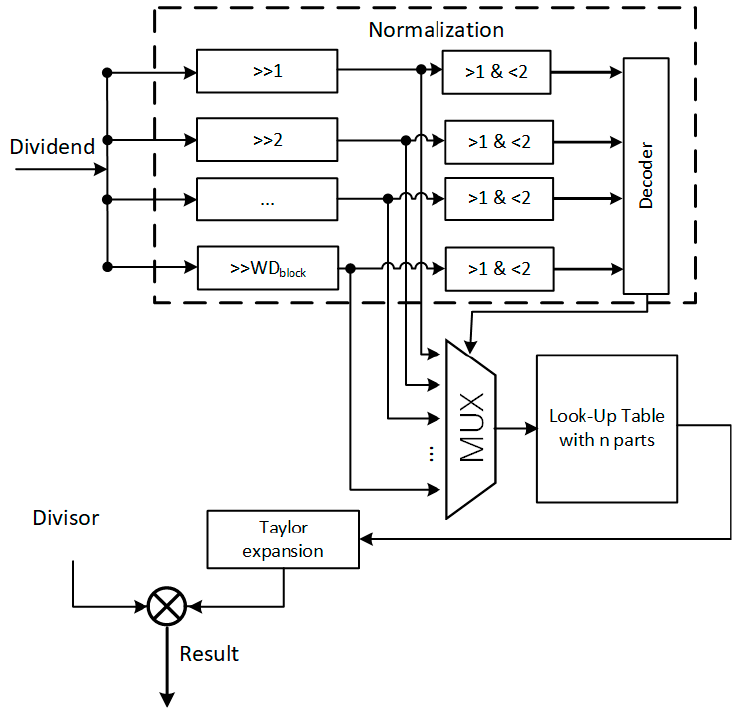
Figure 4. Optimized divider. The dividend is normalized into (1,2) and a lookup table is then used to estimate the Taylor expansion of the reciprocal of dividend.